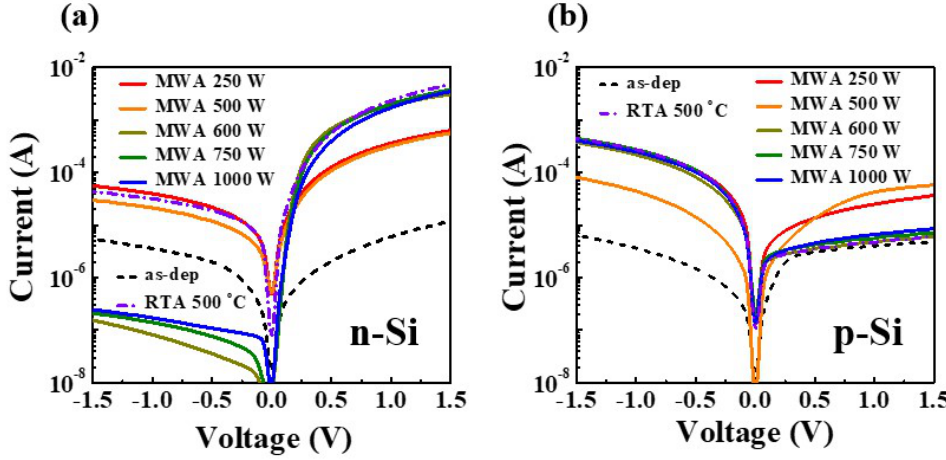
Figure 5. The current–voltage (I-V) curves of the NiSi x SB-diodes on ( a ) n-type and ( b ) p-type Si substrates according to the various silicidation conditions. Table 1. The electrical parameters of n-type and p-type NiSi x SB-diodes obtained by various silicide